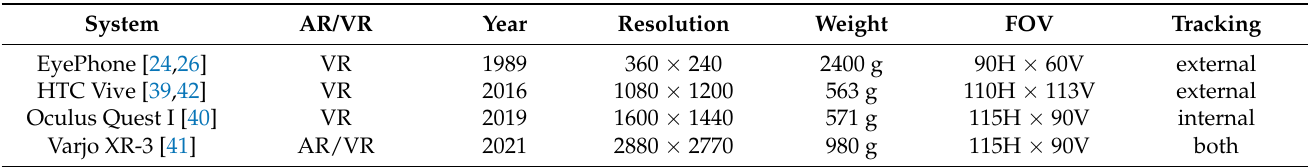
Table 2. Technical details of VR-headsets .